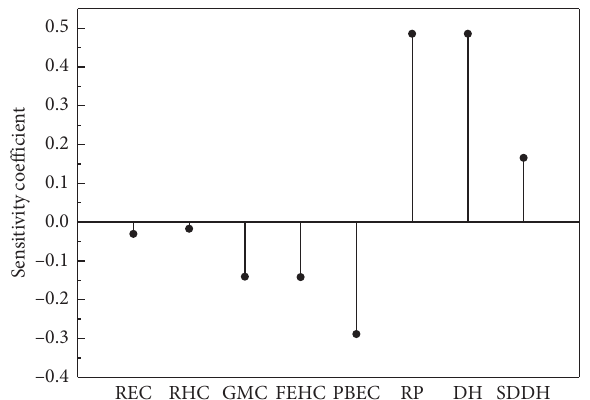
Figure 19: The sensitivity coefficient of the selected 8 inputs to the peak fuel